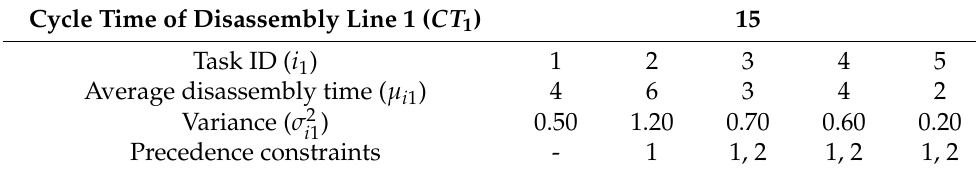
Table 2. The information of product A on disassembly line 1.